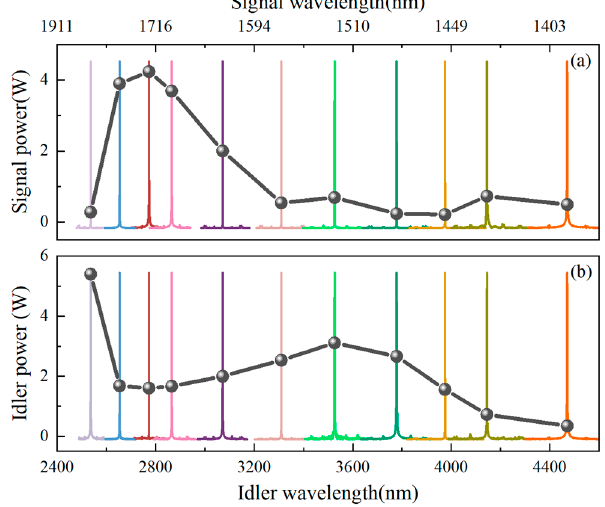
Figure 3. Output power (dashed curve) and corresponding spectrum (solid curve) of ( a ) signal beam and ( b ) idler beam.